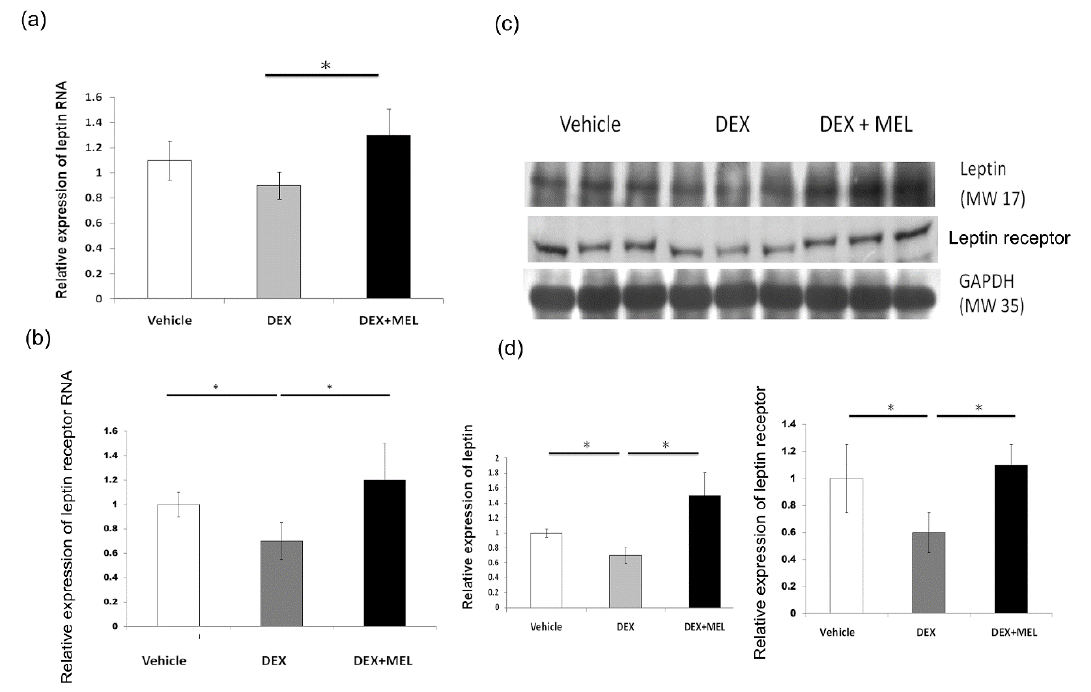
Figure 2. Leptin expression and methylation. ( a , b ) Real-time PCR study. The levels of leptin and leptin receptor expression decreased in the DEX group compared with that in the vehicle group and increased in the DEX+MEL group. ( c ) Western blotting showed decreased leptin and leptin receptor expression in the DEX group compared with that in the vehicle group. This expression was restored in the DEX+MEL group. ( d ) Semi-quantification of Western blot expression of leptin and leptin receptor. All results represent the mean ± standard error of six animals; * p < 0.05 when comparing DEX with the vehicle group or DEX+MEL with the DEX group. The letters represent different groups. DEX, prenatal dexamethasone; DEX+MEL, melatonin treatment after prenatal